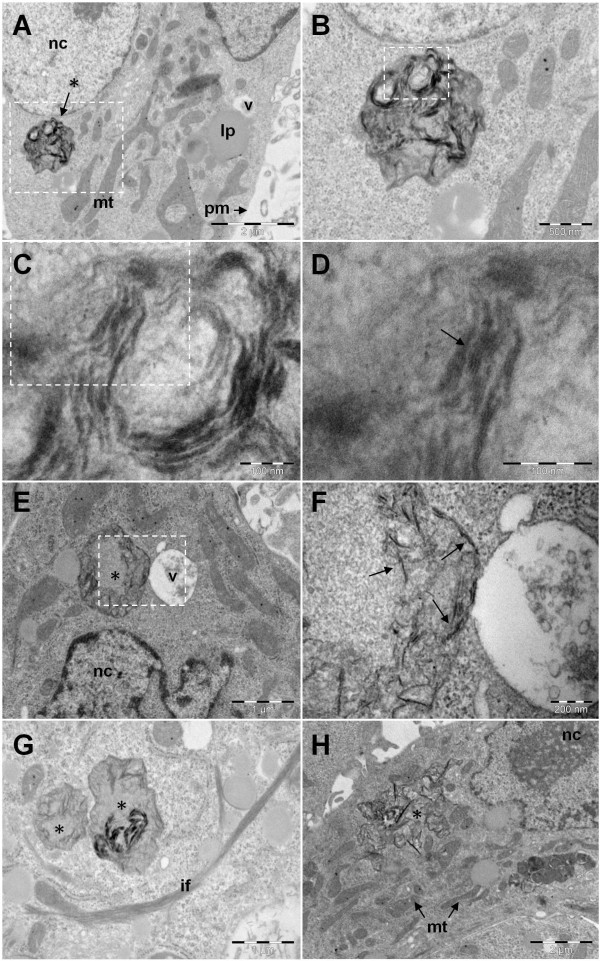
Intracellular fate of CXYG nanoplatelets. Images A, B, C and D show SEM micrographs of an intracellular CXYG nanoplatelets aggregation (black arrow with asterisk) at different magnifications (50 k, 250 k, 300 k and 400 k X, respectively). The boxed-in areas indicate the part of the image that was amplified in the image of next higher magnification, respectively. Image E shows the interaction of an intracellular CXYG aggregation (black asterisk) with a vacuole (v). The site of interaction between the two compartments is represented at higher magnification in F. Image G shows two intracellular CXYG aggregates (black asterisk) in close proximity to each other and surrounded by intermediate filament bundles (if). H shows the ultrastructure of a cell exposed to CXYG for 72 h. The black asterisk indicates the site of CXYG accumulation. The scale bar displayed in A and H corresponds to 2 μm. The scale bars in B and H are 500 nm. The scale bars represented in C and D correspond to 100 nm. The scale bar in E and G is 1 μm. Other cellular structures indicated in Figure 11 are indicated as followed: pm: plasma membrane, nc: nucleus, mt: mitochondrion, lp: lipid, v: intracellular vacuole.